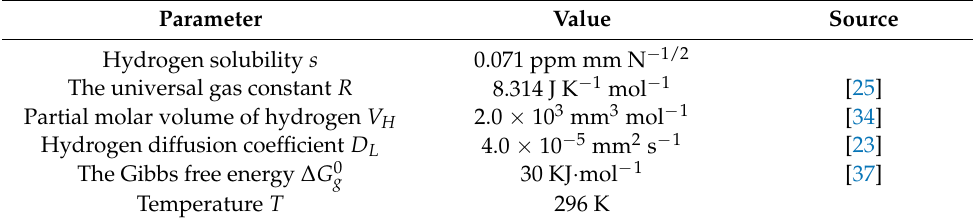
Table 3. Values of the parameters adopted in the